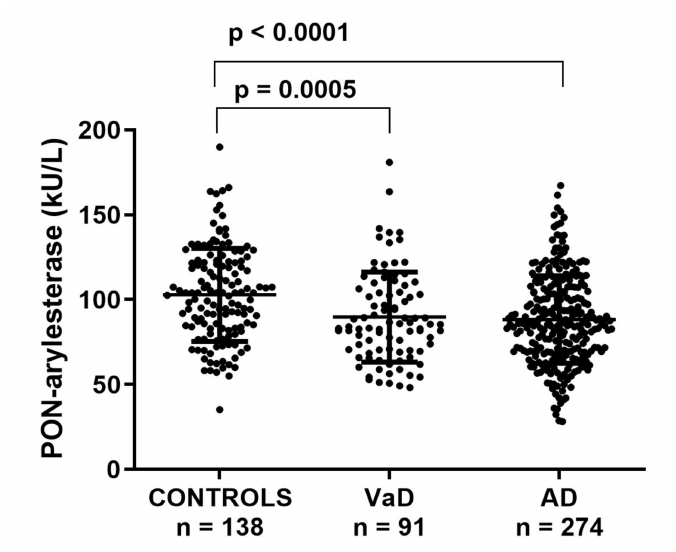
Figure 1. Scatter plots displaying serum PON-arylesterase activity in CONTROLS ( n = 138), VaD ( n = 91), and AD ( n = 274) patients, within FC. Statistical analysis was performed using ANOVA followed by Sidak post-hoc test. Abbreviations: VaD, vascular dementia; AD, Alzheimer’s disease, PON,